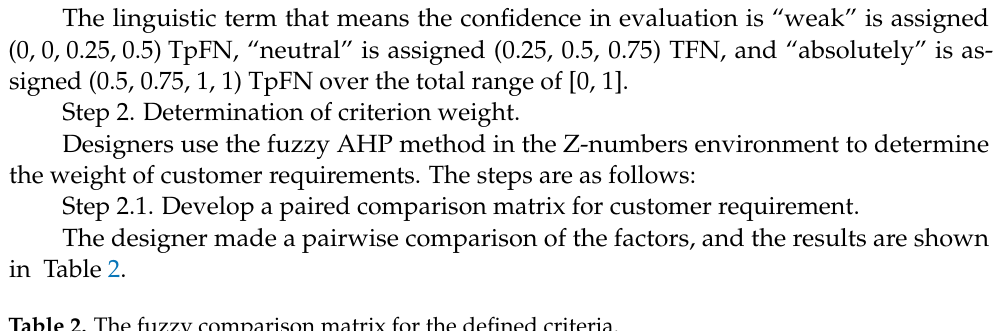
Table 2. The fuzzy comparison matrix for the defined criteria.